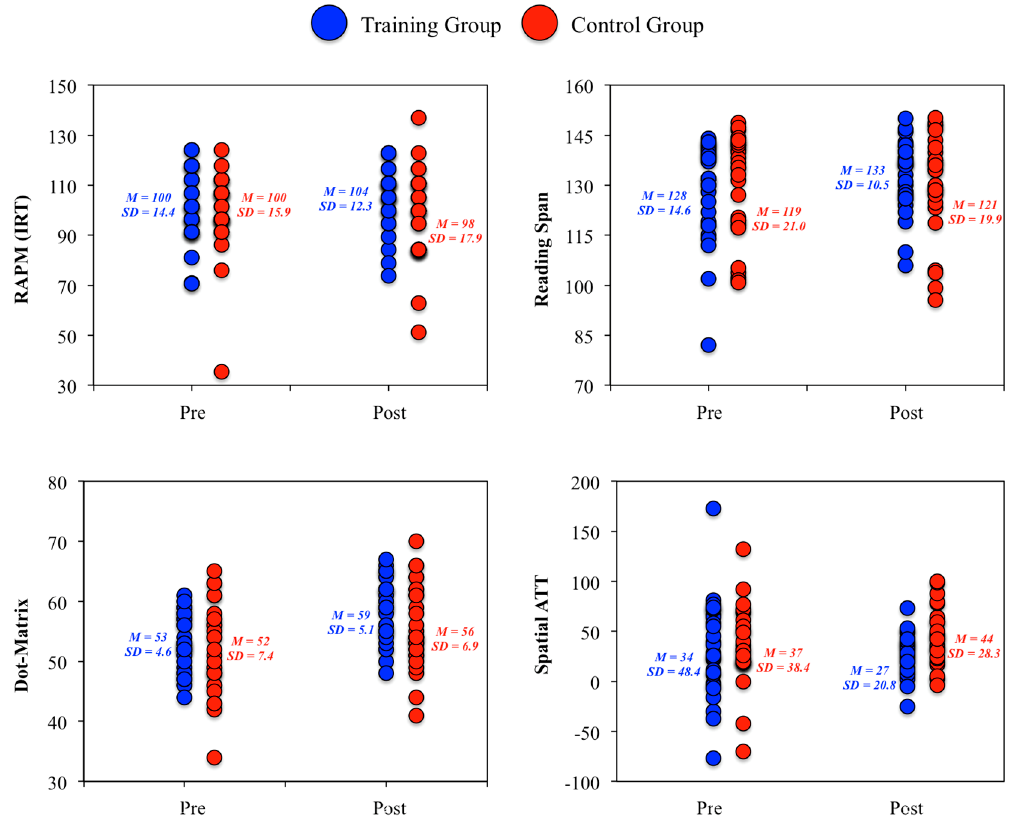
Figure 4. Individual changes in the RAPM (Raven Advanced Progressive Matrices) test, the Reading span working memory task, the Dot Matrix working memory task, and the Spatial attention control